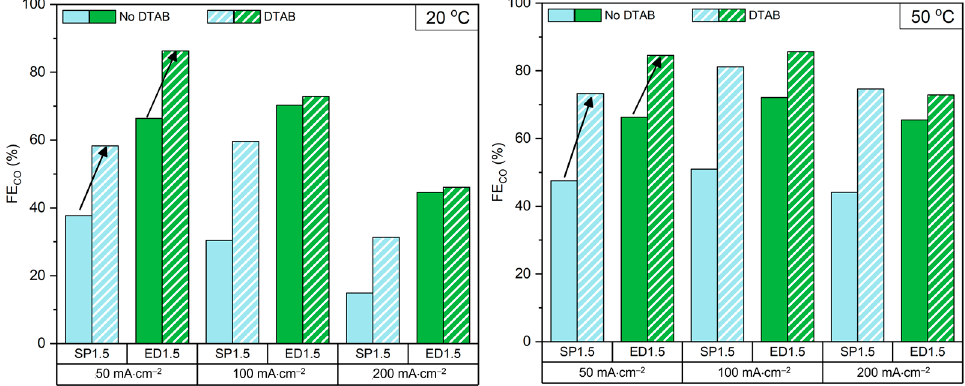
Figure 3. FE CO of the SP1.5 and ED1.5 cathode, with and without DTAB in the catholyte, at 20 °C and 50 °C.